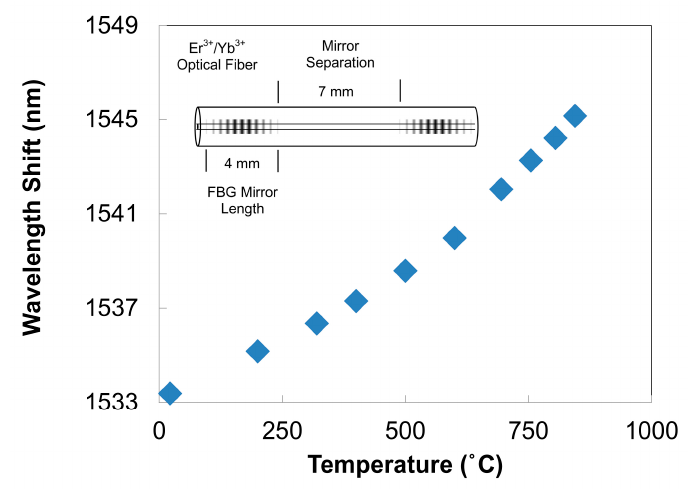
Figure 18. Wavelength variation of a fiber laser cavity comprising fs-FBGs with temperature. Inset: schematic of the fiber laser cavity.